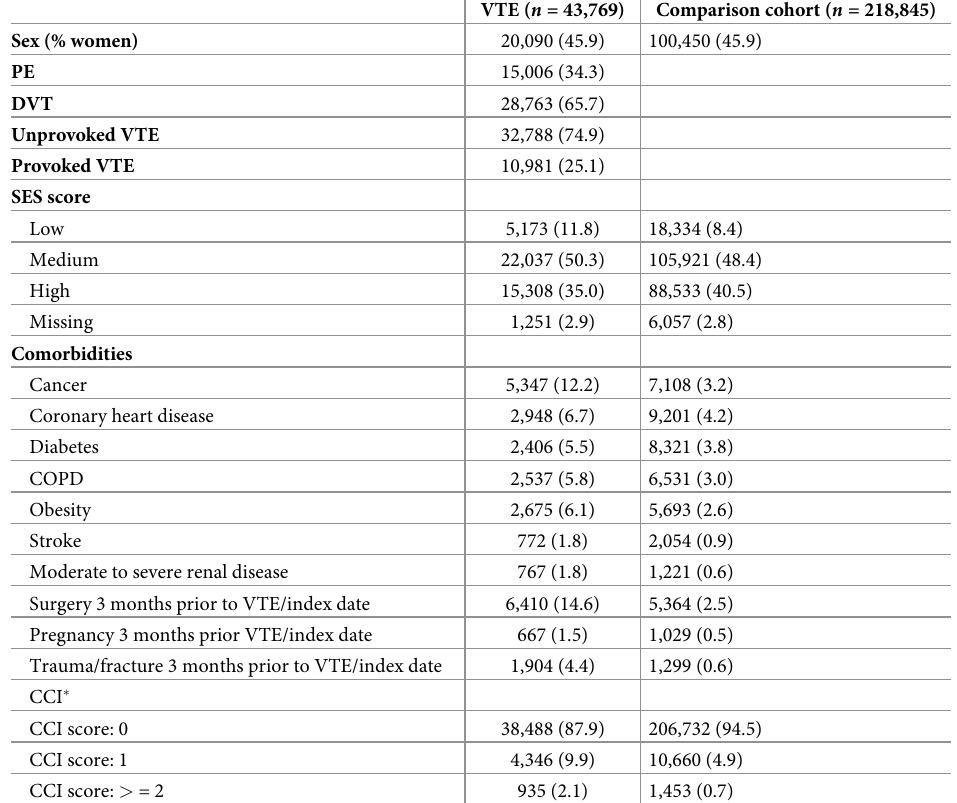
Table 1. Baseline characteristics of persons with VTE and members of the general comparison